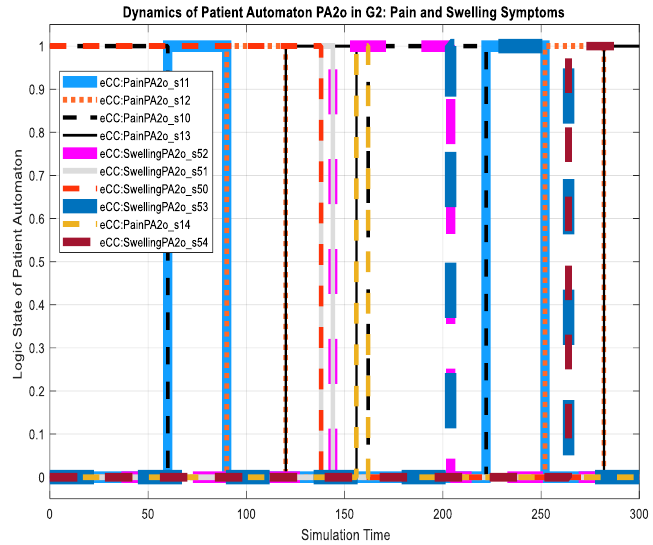
Figure 25. Dynamics of patient automaton 𝑷𝑨 𝟐𝒐 in 𝑮 𝟐 in terms of the key symptoms: pain and swelling.